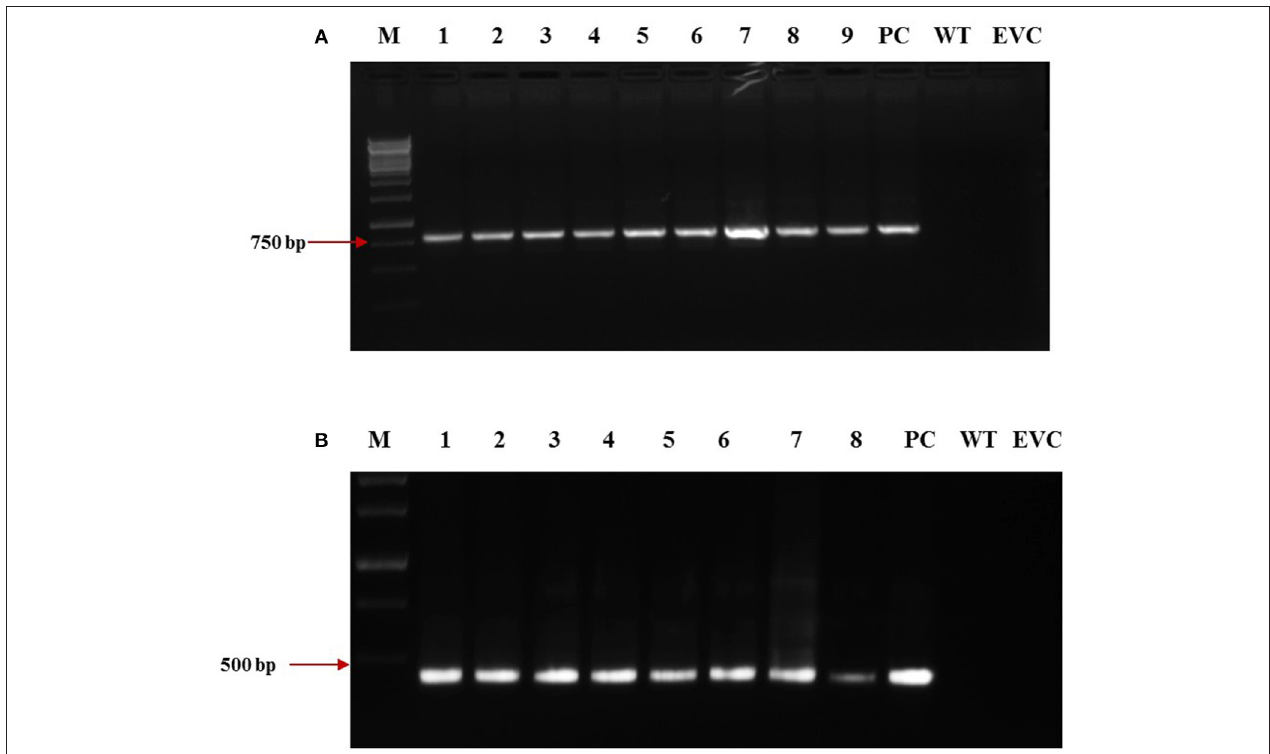
FIGURE 4 | Molecular confirmation of T 0 transgenic events for the presence of the transgene through PCR using gene specific primers. (A) Amplification of Mi-col-1 insert from the DNA isolated from putatively transgenic events of Mi-col-1. Lane M: 1kb ladder, lanes 1–9: T 0 transgenic events, lane PC: positive control (pGEMT clone of Mi-col-1 ), lane WT, Wild type; lane EVC, Empty vector control; (B) Amplification of Lemmi-5 insert from the DNA isolated from putatively transgenic events of Lemmi-5. Lane M: 1kb ladder, lanes 1–8: T 0 transgenic events, lane PC, positive control (pGEMT clone of Lemmi-5 ); lane WT, Wild type; lane EVC, Empty vector control.